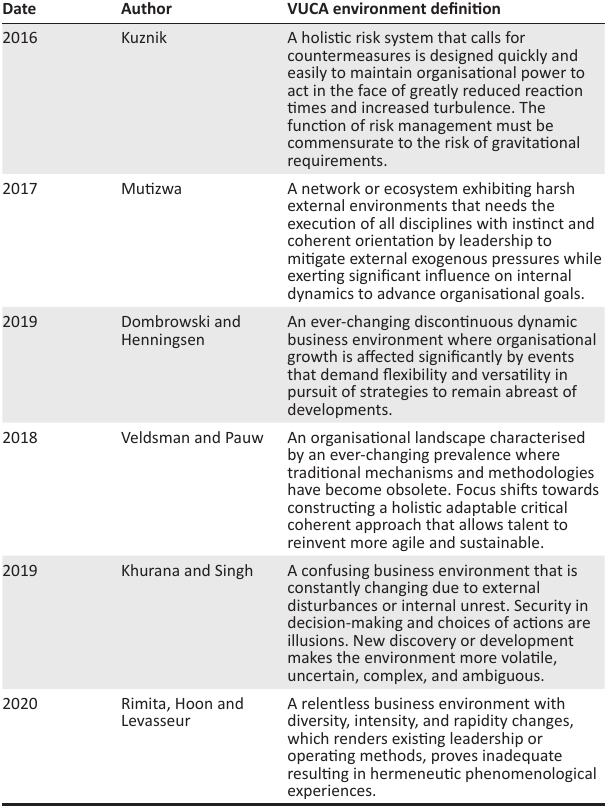
TABLE 1 : Definitions of a volatile, uncertain, complex and ambiguous business